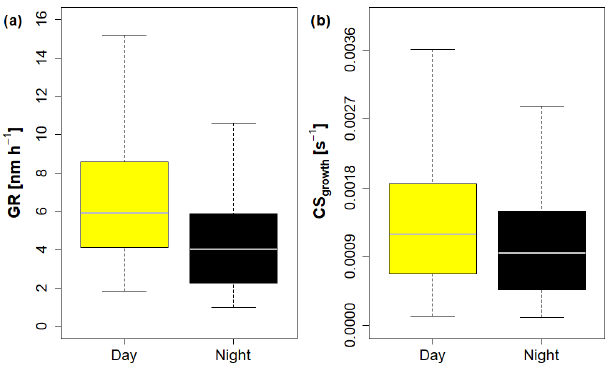
Figure 8. Box plot of (a) GR and (b) CS growth related to growth events that occurred during the day or night. Nighttime events occurred between 19:00 and 05:00LT, while daytime events oc- curred between 06:00 and 18:00LT. The box represents the quar- tiles, whiskers represent 90th and 10th percentiles, and the horizon- tal lines represent the